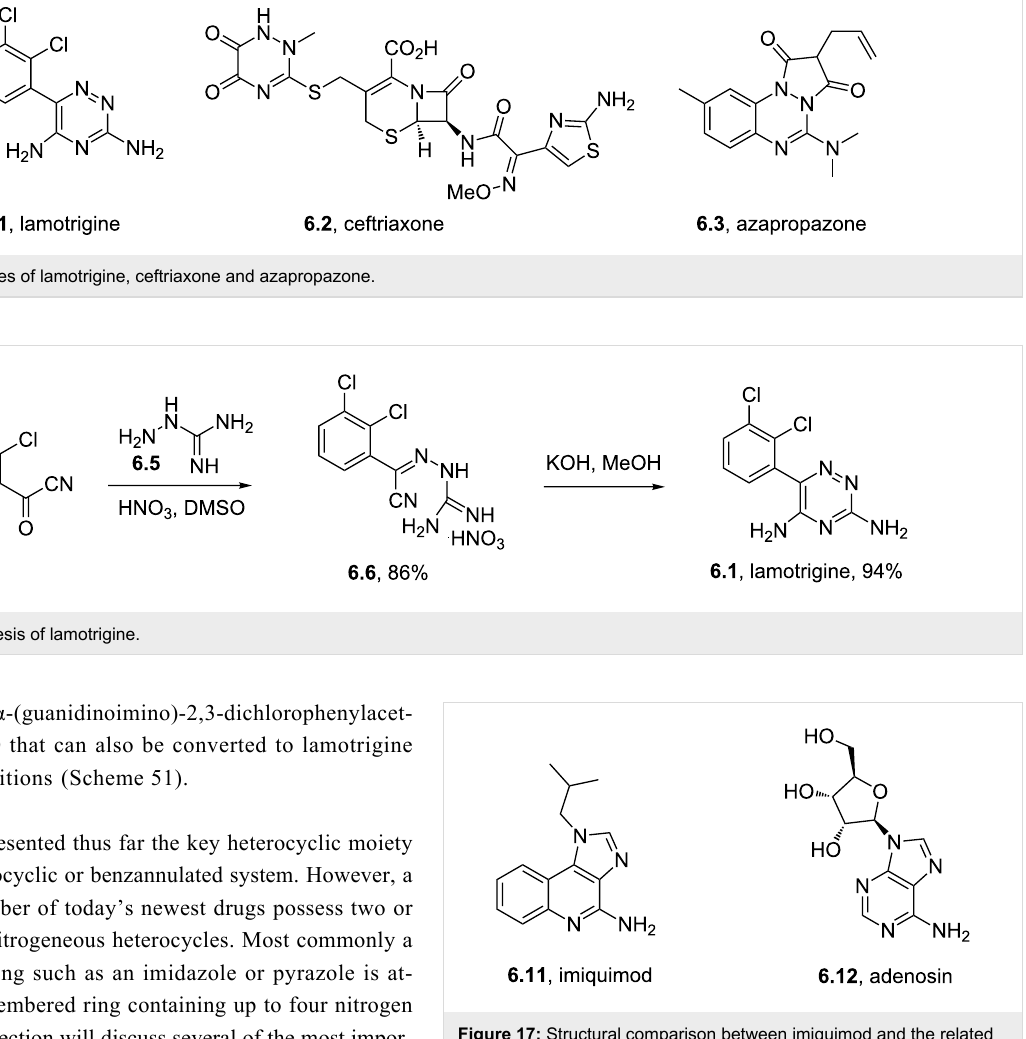
Imiquimod ( 6.11 ) can be obtained through several